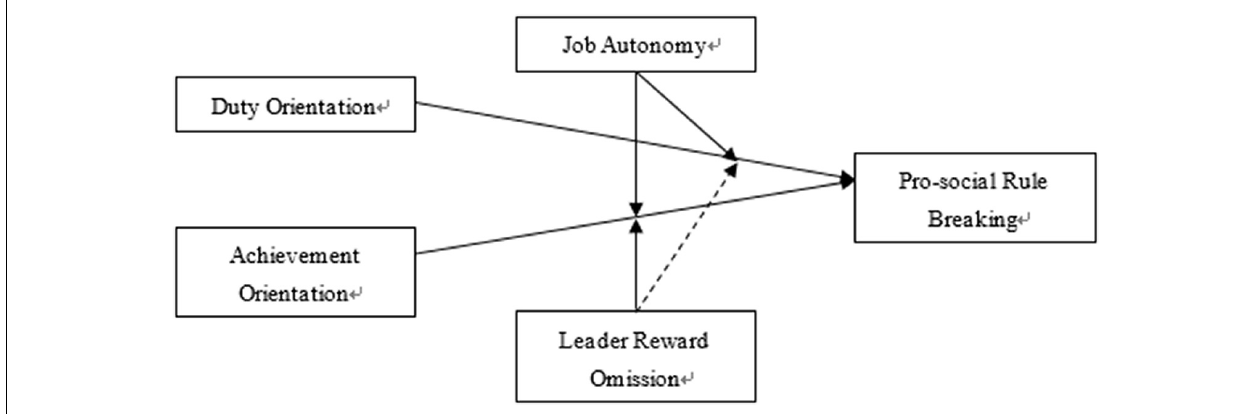
FIGURE 1 | Conceptual model.